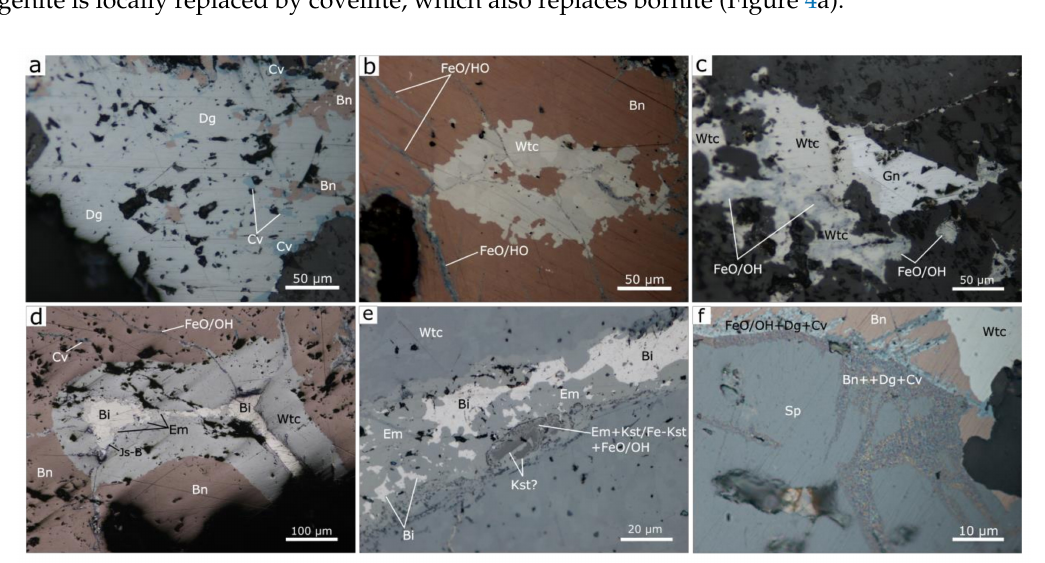
Figure 4. Photomicrographs in plane-polarized reflected light of Cu-Bi-Sn ore from the Blidar Contact orebody; ( a ) bornite replaced by digenite and covellite; ( b ) wittichenite nest hosted by bornite; ( c ) wittichenite-galena assemblage with partial replacement of wittichenite by Fe-oxides / hydroxides; ( d ) native bismuth filling a vug within bornite associated with emplectite and jos é ite-B and a well-developed border of wittichenite; ( e ) irregular grains of kësterite(?) surrounded by emplectite and a mixture phase; ( f ) detail of bornite-sphalerite contact. Abbreviations: Bi: native bismuth, Bn: bornite, Cv: covellite, Dg: digenite, Em: emplectite, FeO / OH: Fe oxides / hydroxides, Gn: galena, Js-B: jos é